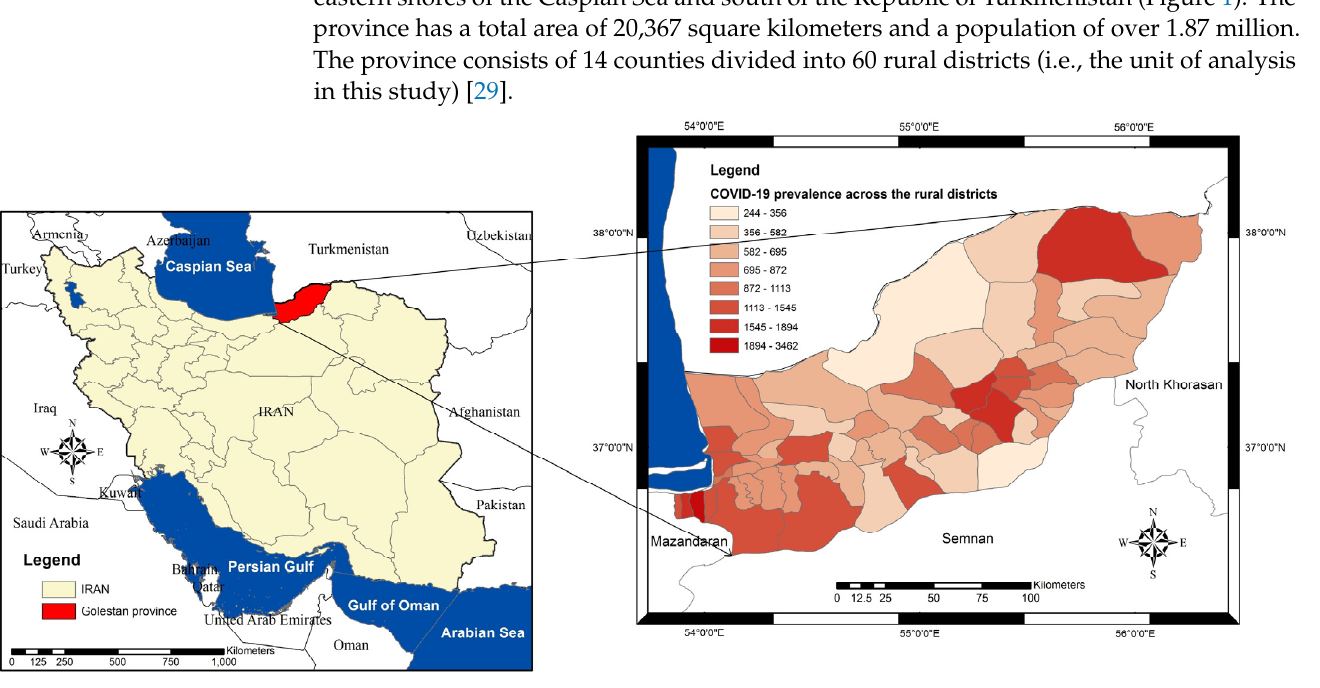
Table 1. Summary of the dataset used in this study.